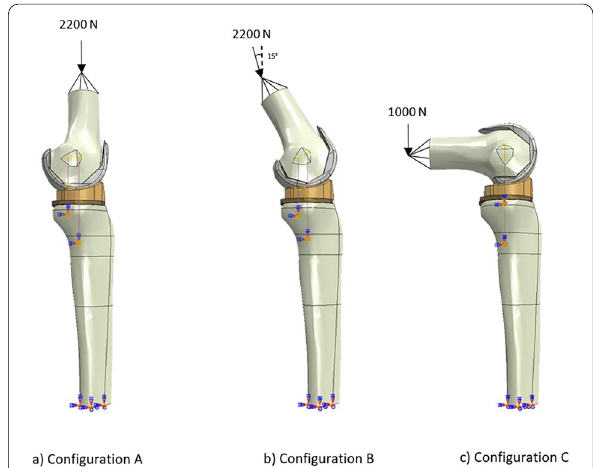
Fig. 3 Illustration of the forces applied to the MB CR model in the three analyzed